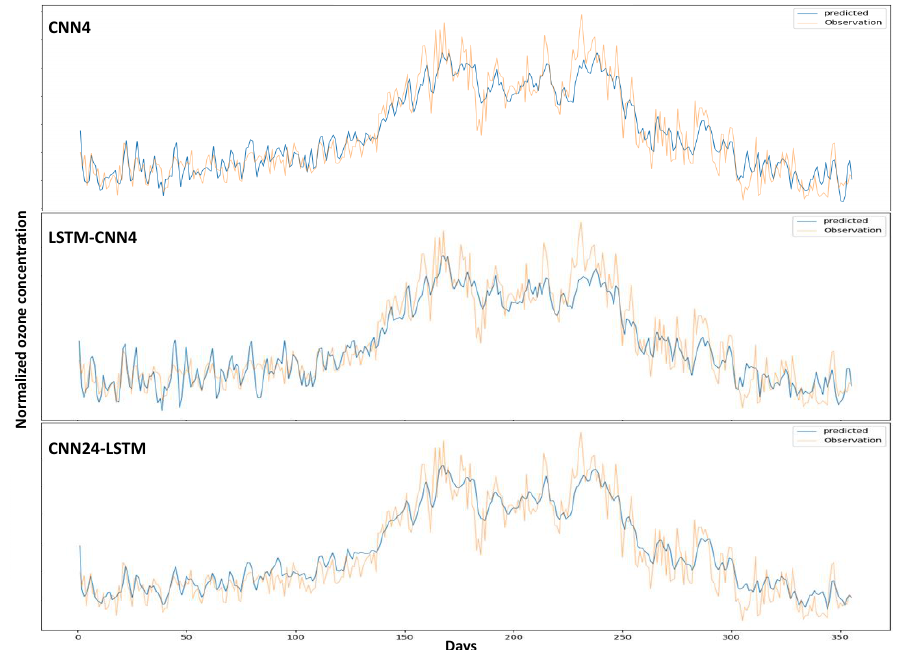
Figure 11. Yearly ozone forecasting by the proposed three models over Esenyurt